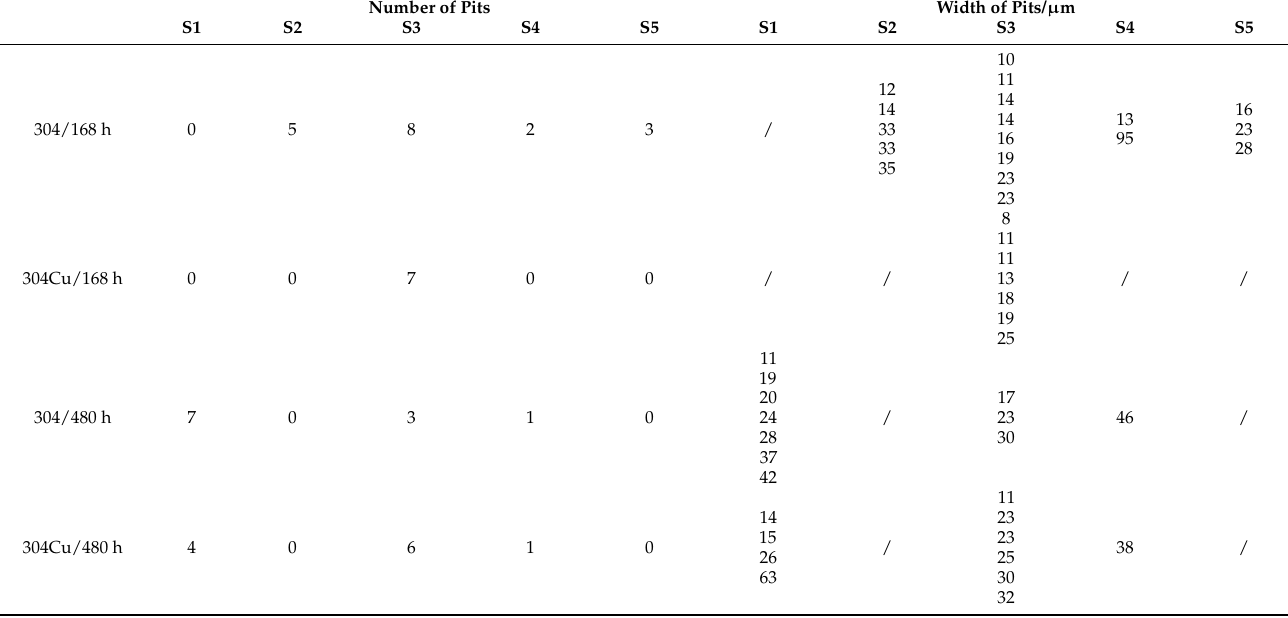
Figure 2. Number (figure in black boxes) and width of pits on 304 and 304Cu stainless steel surface after salt spray tests in 5 wt.% NaCl.